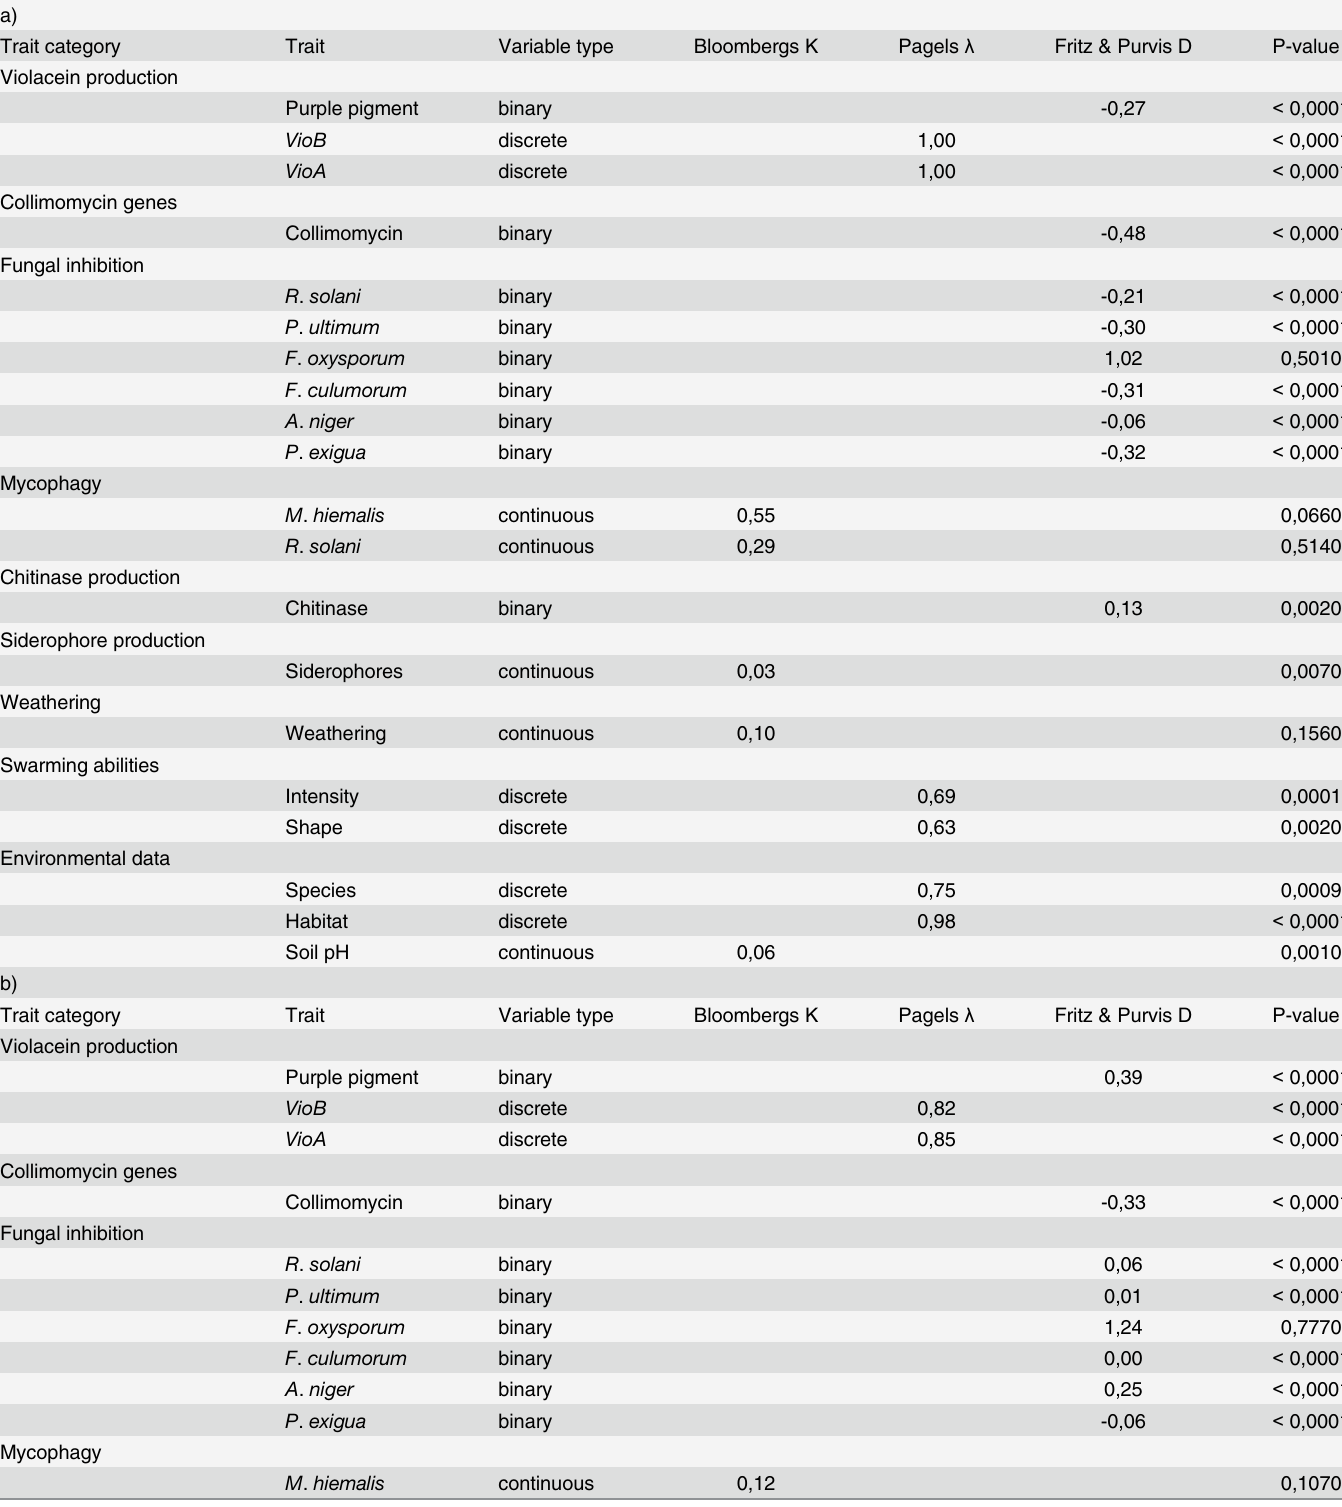
Table 1. Trait phylogenetic